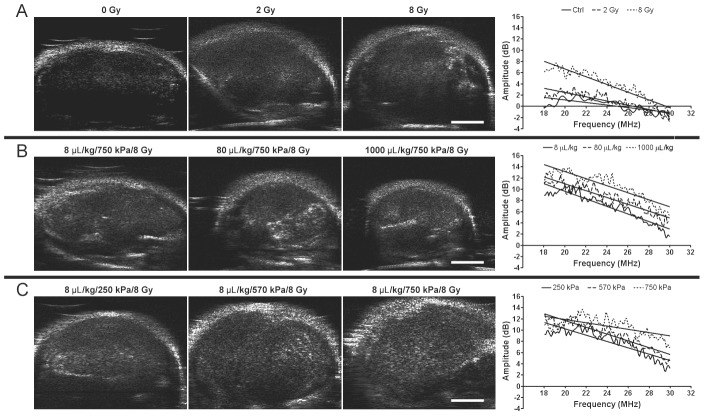
High-frequency ultrasound B-mode images of PC-3 xenografts.B-Mode (left) and on the right side of each row, respective representative normalized power spectra are shown. (A) Tumors treated with varying radiation doses (0–8 Gy) without ultrasound-microbubble treatment. (B) Tumors treated with varying microbubble concentrations (8–1000 µL/kg) combined with 750 kPa of ultrasound pulse and 8 Gy-radiation. (C) Tumors treated with varying ultrasound pressures (250–750 kPa) combined with 8 µL/kg of microbubbles and 8 Gy-radiation. The scale bar represents 2 mm.